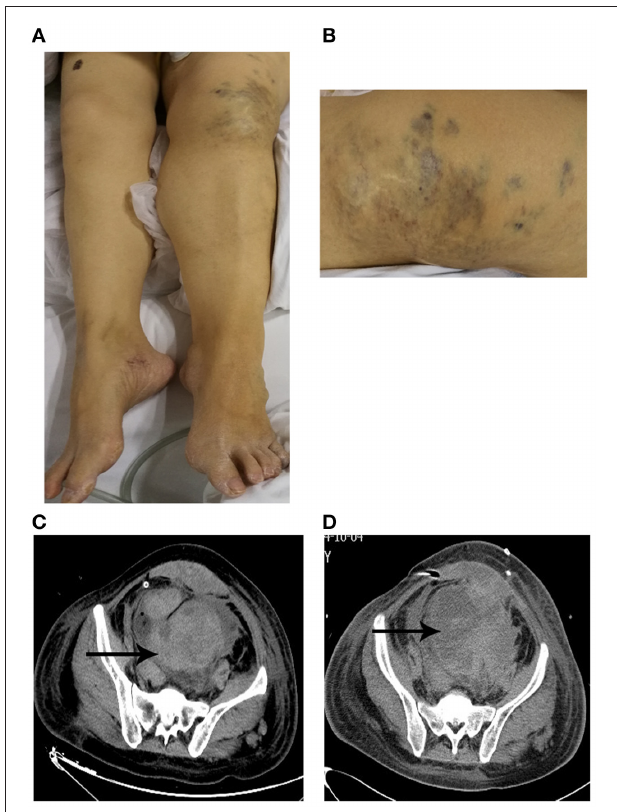
FIGURE 1 | (A,B) Patient with Klippel–Trenaunay syndrome. (A) The left leg was larger in circumference and longer in length than the right leg. (B) Capillary malformation in the left leg. (C,D) Unenhanced computer tomography (CT) showed peritoneal diffuse effusion in pelvis with different mixed attenuation values at the admission to our department (C) and post-operative period (D)